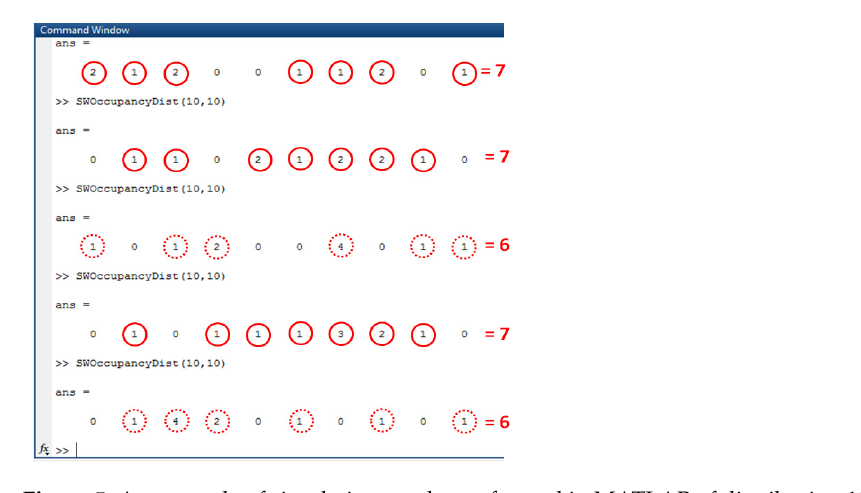
Figure 5. An example of simulation results performed in MATLAB of distributing 10 beacons over the SW of 10 STTs. Figure 6 show the occupancy probability when varying the number of occupied STTs.